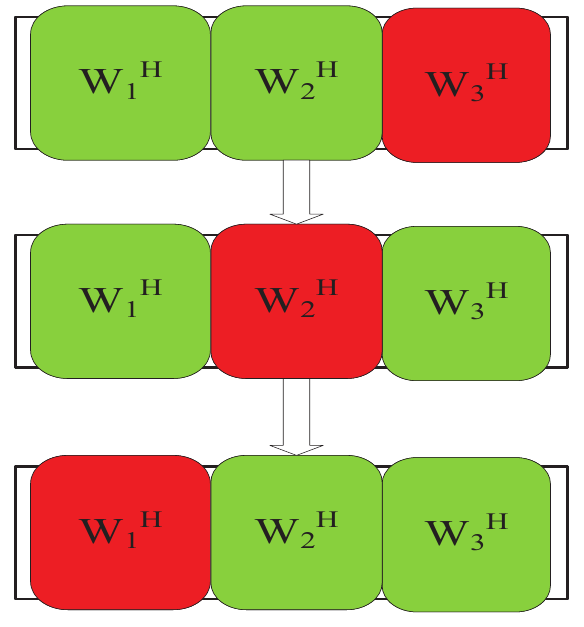
Figure 8. ISS update